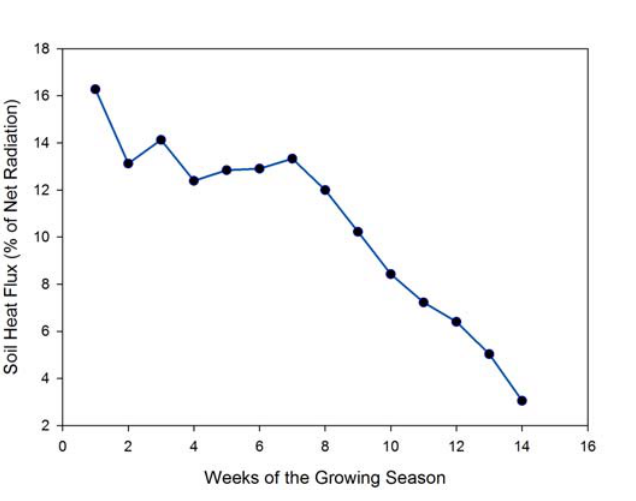
Figure 3. Mean soil heat flux conducted into the soil as a percentage of the net radiation during the growing season at